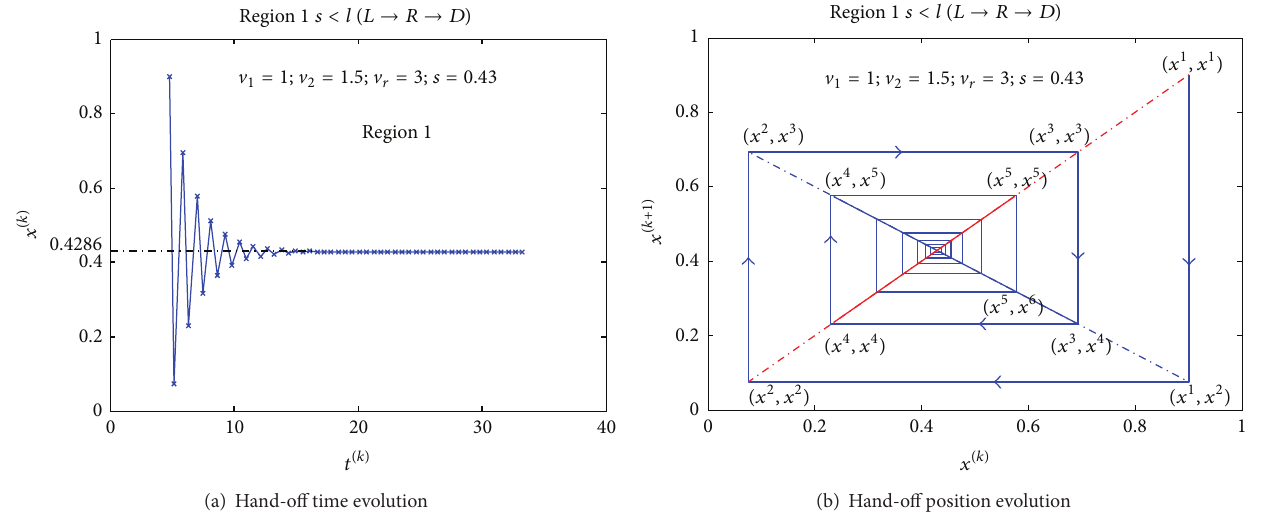
Figure 3: Convergence process in Region 1 when the picking routes are sequenced as 𝐿 → 𝑅 → 𝐷 .